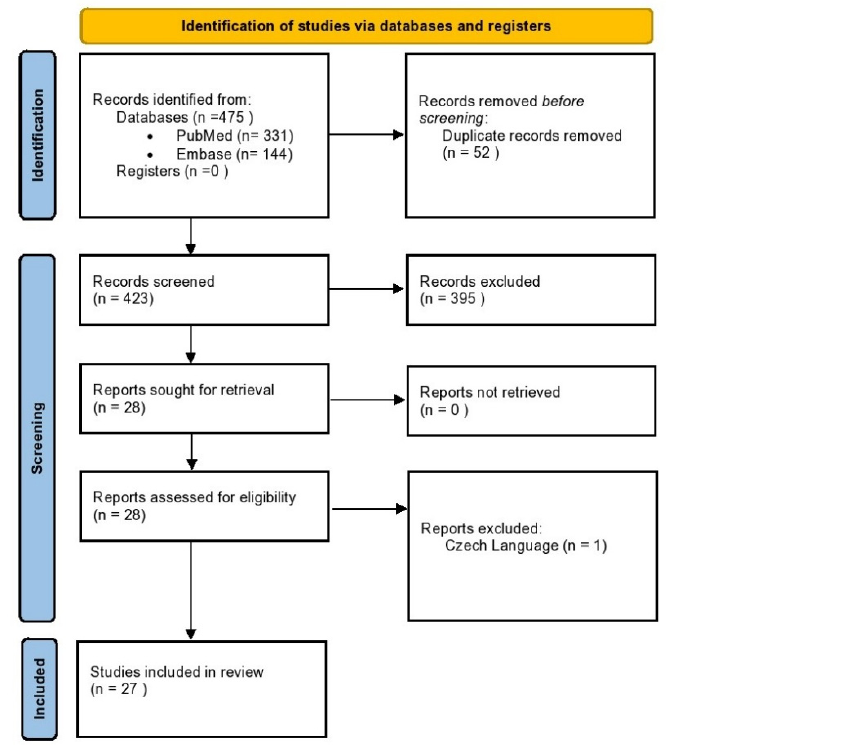
Figure 1. PRISMA flowchart of the study selection process.